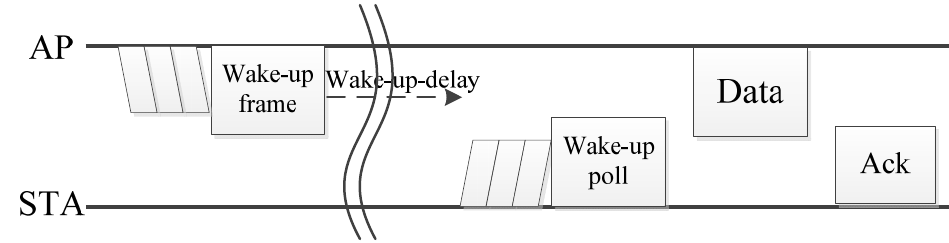
Figure 3. Wake-up radio transmission procedure in IEEE 802.11ba. STA = station; AP = Access Point.